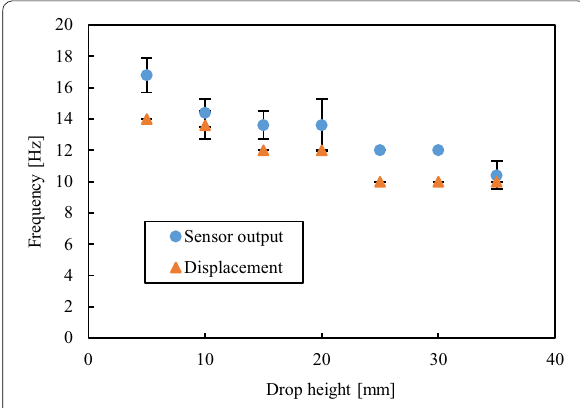
Fig. 9 Relationship of peak values between displacement of sensor tip and filtered sensor output